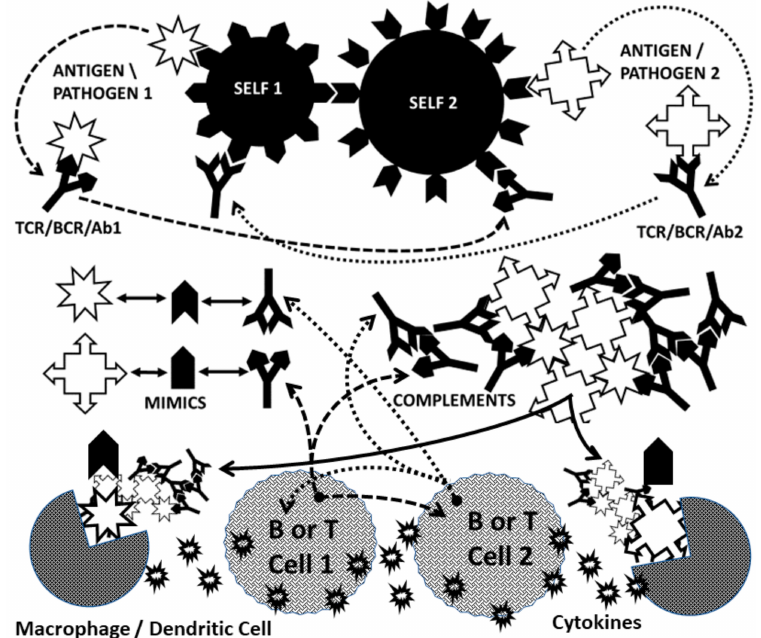
Figure 6. Schematic diagram of the complementary antigen theory (CAT). CAT integrates all of the AD theories described in Figures 2–5 with important modifications. Instead of one antigenic trigger, CAT, like BAT, posits two. Unlike BAT, however, CAT requires that the triggering antigens be molecularly and antigenically complementary to each other. Each of these triggering antigens mimics a host (or self) antigen. These host antigens are themselves complementary to each other (though they may not directly interact as in this figure, which is drawn simply to illustrate their complementarity). As in MMT, Antigen 1 will elicit a complementary T or B cell response that will, in turn, recognize the host mimic of that antigen (labeled here as Self 2) as an autoimmune target. Concurrently, again as in MMT, Antigen 2 will elicit a complementary T or B cell response that recognizes the host mimic of that antigen (labeled here as Self 1) as an autoimmune target. It follows from the fact that the initiating antigens are complementary to each other, so their resulting immune responses are complementary to each other. In other words, although each immune response is idiotypic, they will have an idiotype-anti-idiotype relationship to each other, thus incorporating AIT. Finally, CAT integrates BAT in that the immune responses to both triggering antigens occur simultaneously so that each acts as a bystander activator for the other. Tolerance to host antigens in CAT is broken by the fact that immune system can no longer di ff erentiate between triggering antigens, host antigens and its own idiotypic responses. The result is that the immune system not only attacks the triggering antigens and the host, but itself, producing circulating immune complexes (if antibody-mediated) and / or perivascular cu ff s (if cell-mediated). This immunological “civil war” will continue to drive the AD long after the initiating antigens are gone because of the attacks of adaptive cells on each other (here illustrated by antibodies against complementary B cell receptors, but also possible between idiotypic and anti-idiotypic T cells) and stimulation of monocytes by immune